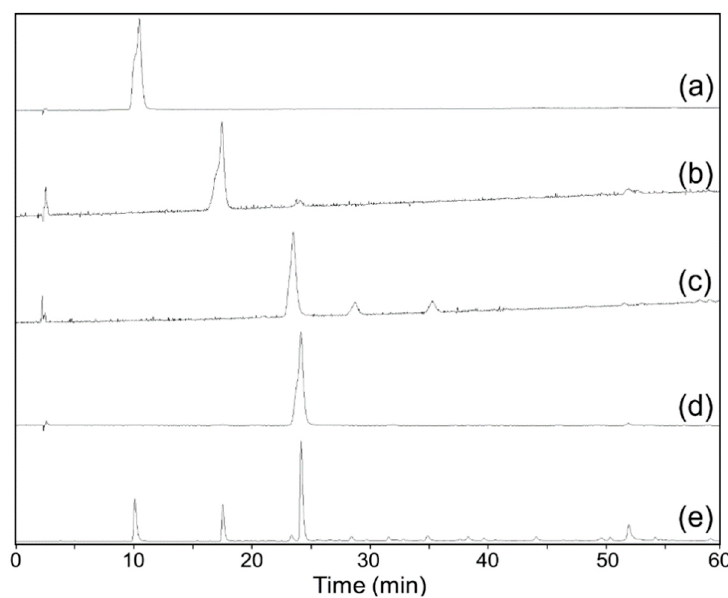
Figure 3. HPLC chromatograms of aldose reductase inhibitors (ARIs) isolated by HSCCC (a–d) and the ethyl acetate fraction of the evening primrose seeds 50% ( v / v ) methanol extract (EME) (e). Gallic acid (a), procyanidin B3 (b), catechin (c), and methyl gallate (d).